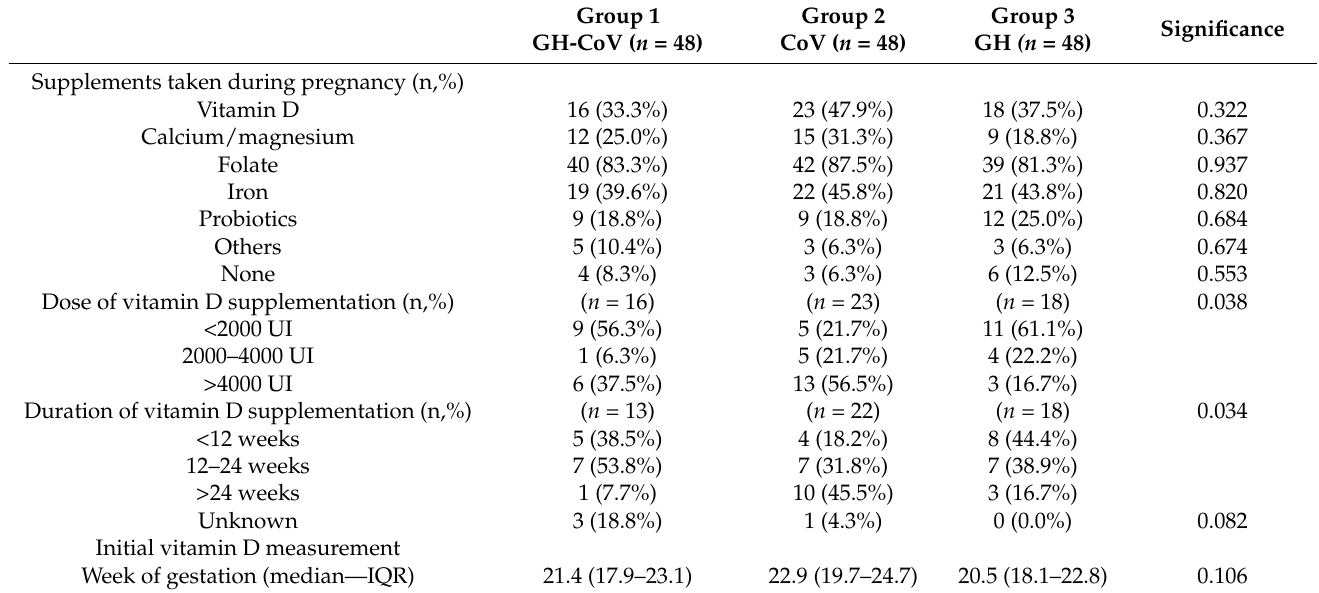
Table 2. Vitamin supplementation